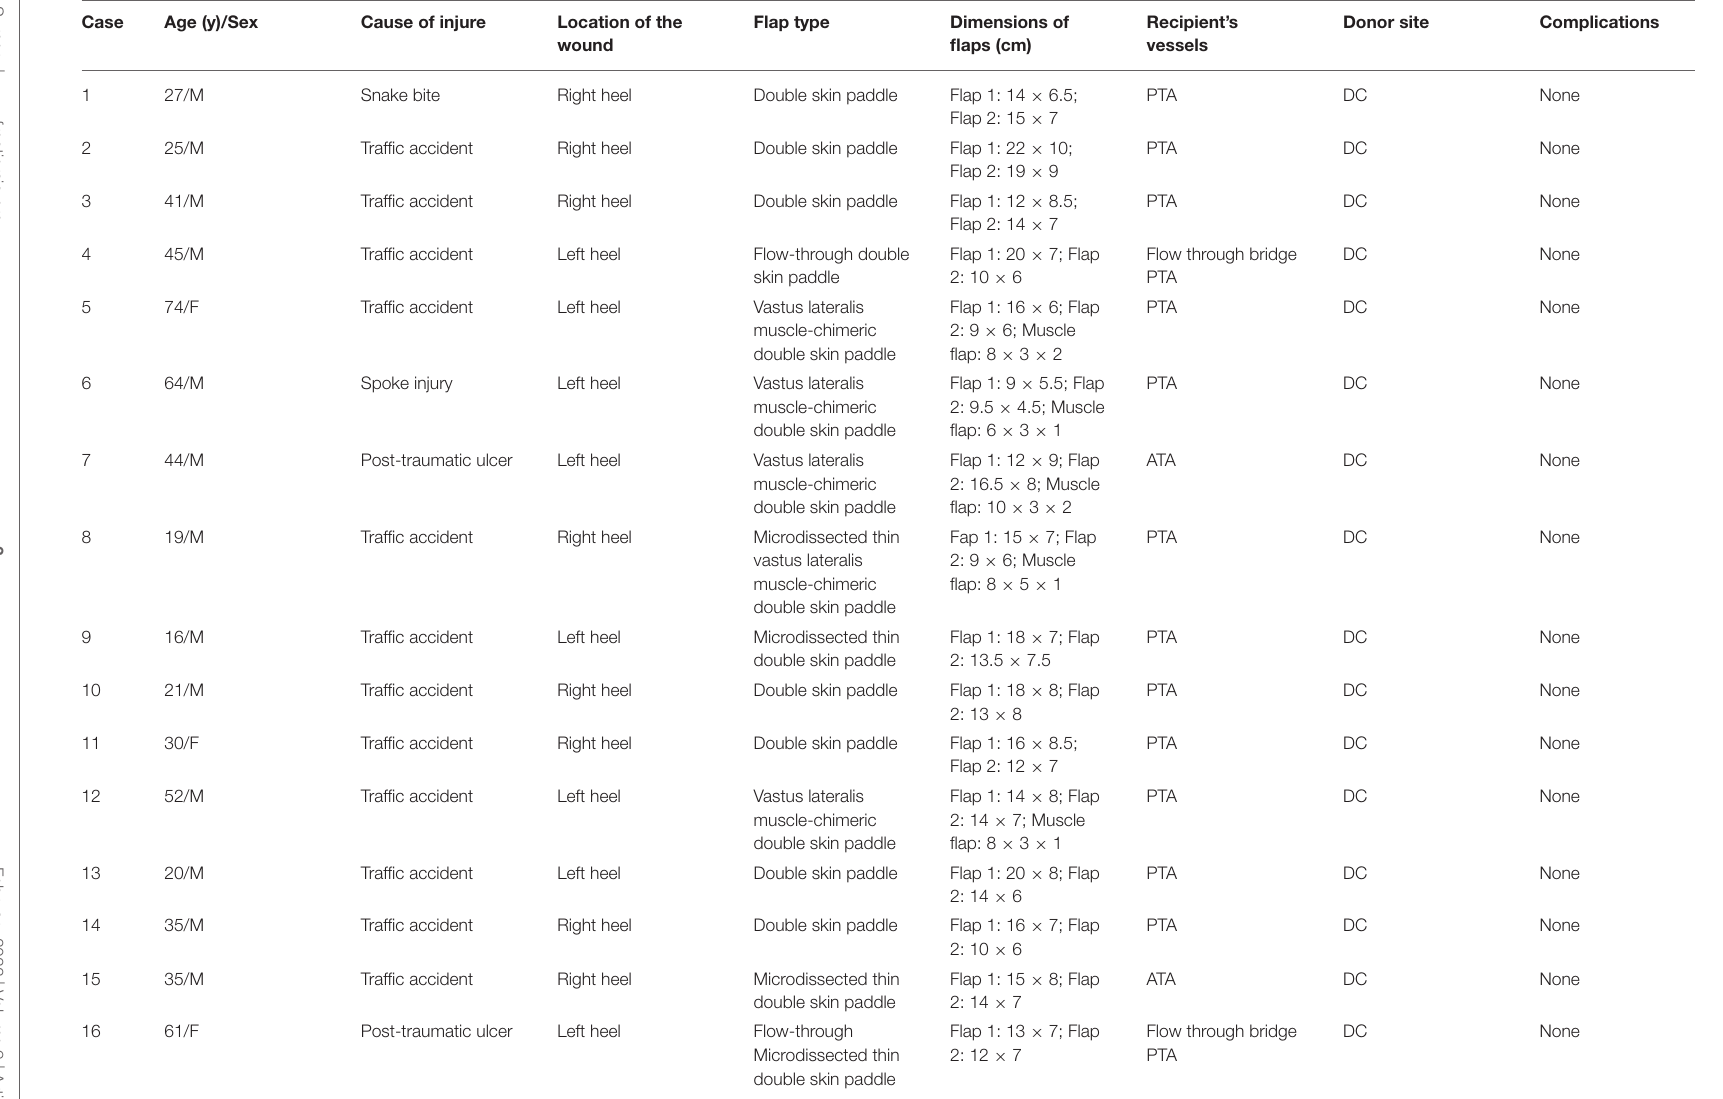
TABLE 1 | Patients’